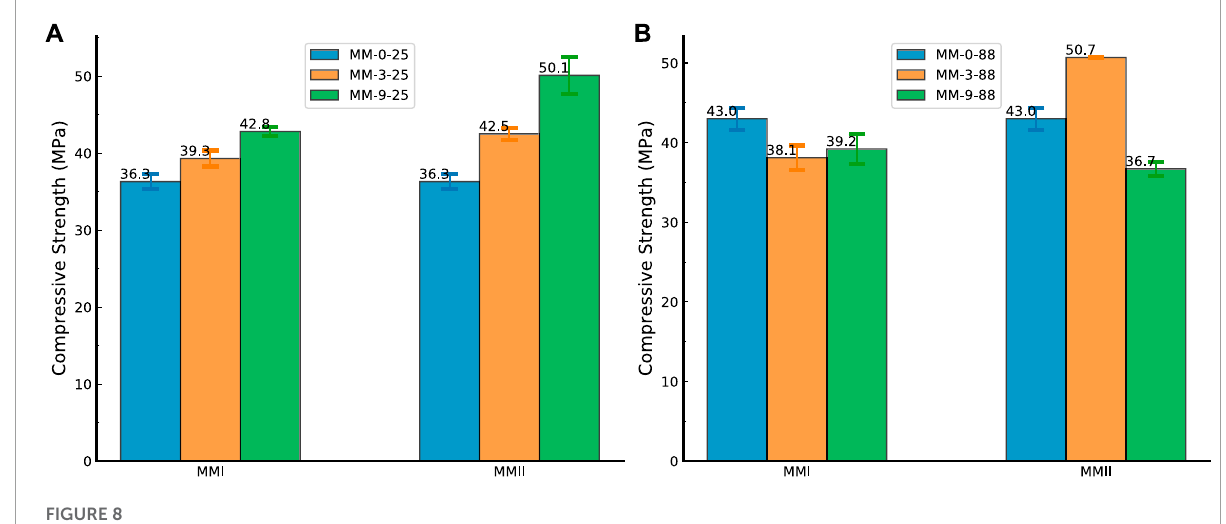
FIGURE 8 Compressive strength of the cement samples after 7 days of curing. (A) Slurry samples (mixed with MMI and MMII, respectively) tested under 25 ° C; (B) slurry samples (mixed with MMI and MMII, respectively) tested under 88 ° C; MMI refers to type I micro-sized magnesium oxide; MMII refers to type II micro-sized magnesium